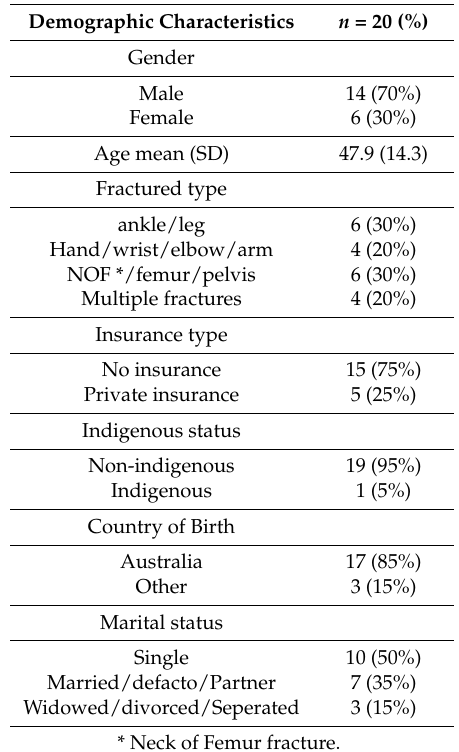
Table 1. Demographics of individuals who completed follow-up phone